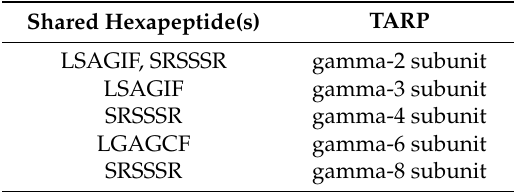
Table 3. Hexapeptide sharing between SARS-CoV-2 epitopes and TARPs.